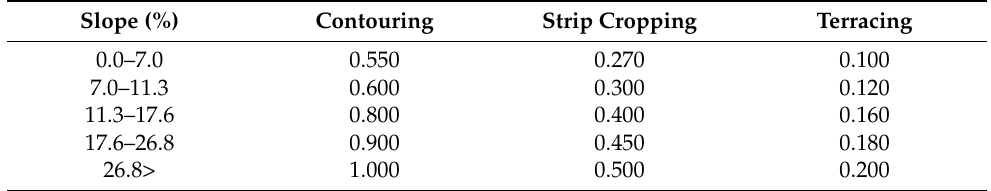
Table 3. Conservation management factor values for contouring, strip cropping, and terracing against